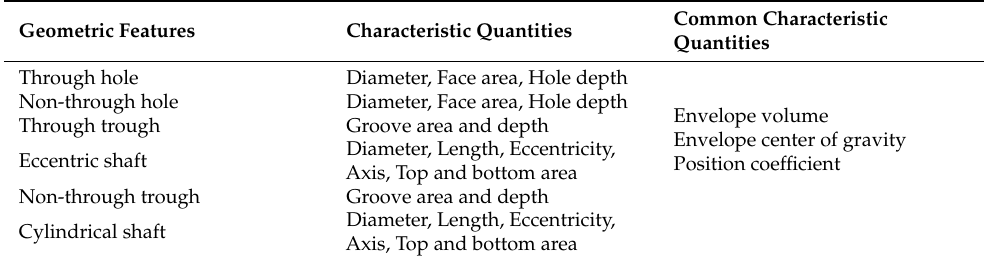
Table 3. Feature quantities of each geometric features.